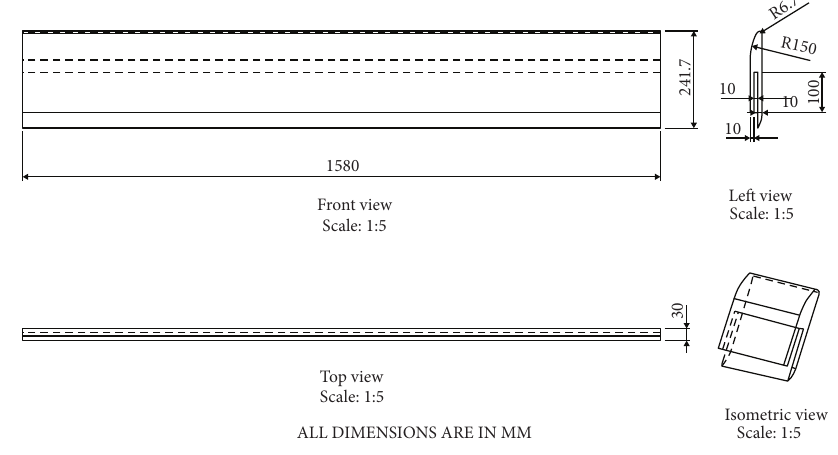
Figure 4: Elevation and plan of rectangular weir.